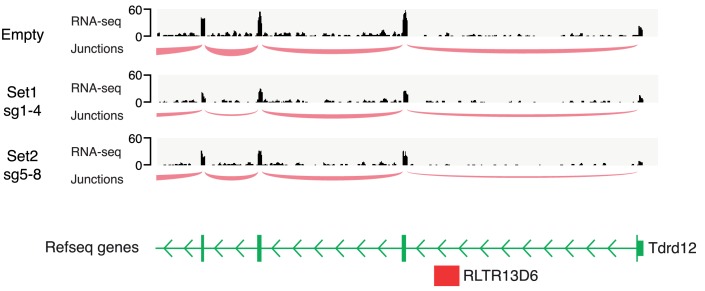
Tdrd12 transcriptional profile.Genome browser snapshot of the Tdrd12 gene displaying RNA-seq data from our CRISPRi experiments in ESCs. Read coverage and splice junction information provide no evidence for use of the intronic RLTR13D6 element as an alternative promoter.